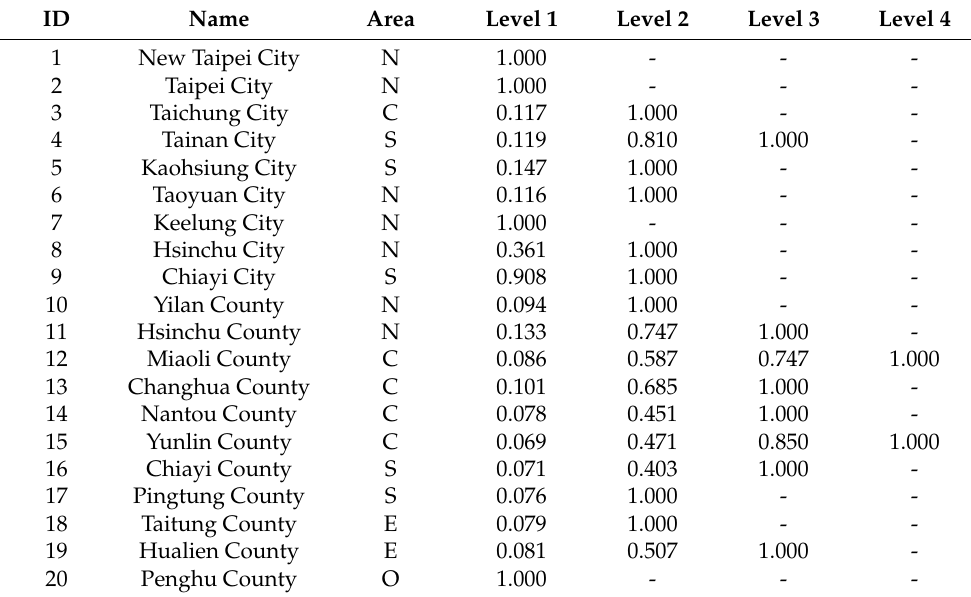
Table 7. Multi-level efficiency frontiers of diesel of counties and cities in